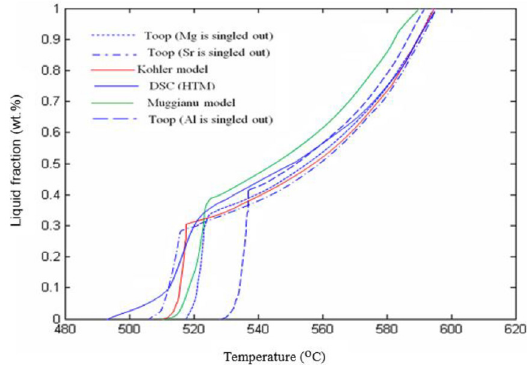
Figure 3. Solidification curves of sample 1(3.32/87.29/9.39, Sr/ Mg/Al, wt.%).